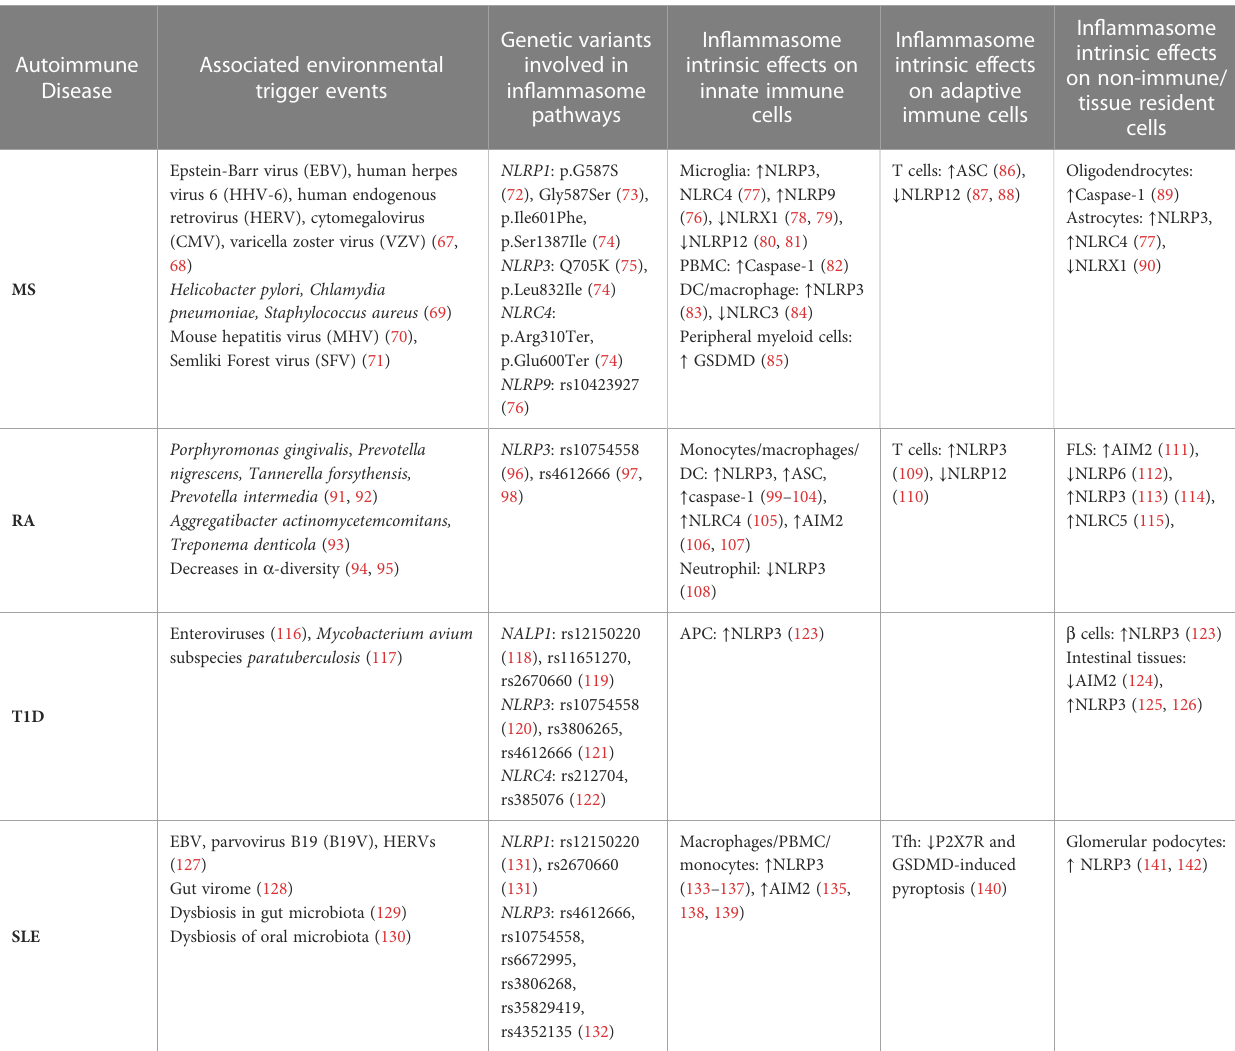
TABLE 1 Intrinsic-effects of classical in fl ammasome-mediated in fl ammation in autoimmunity.